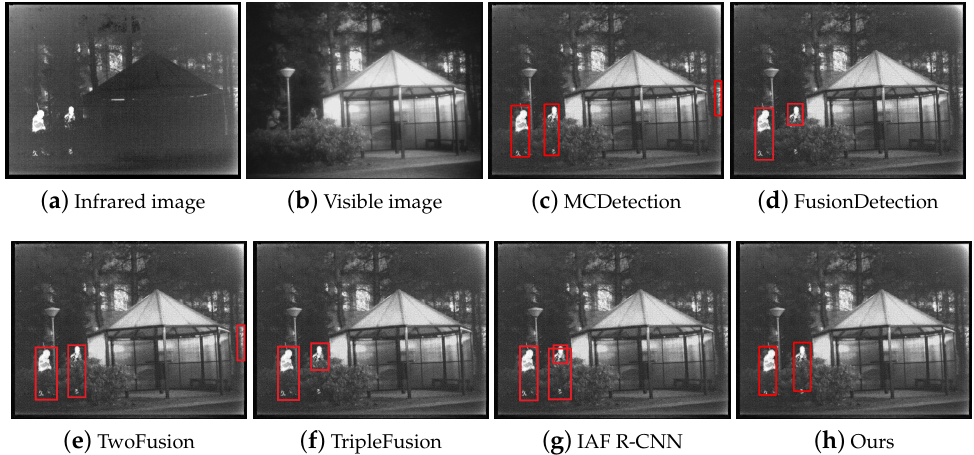
Figure 9. ( a – h ) The infrared and visible image detection results from six different detection methods. In order to better display the results, the detection results are shown on the fused images.